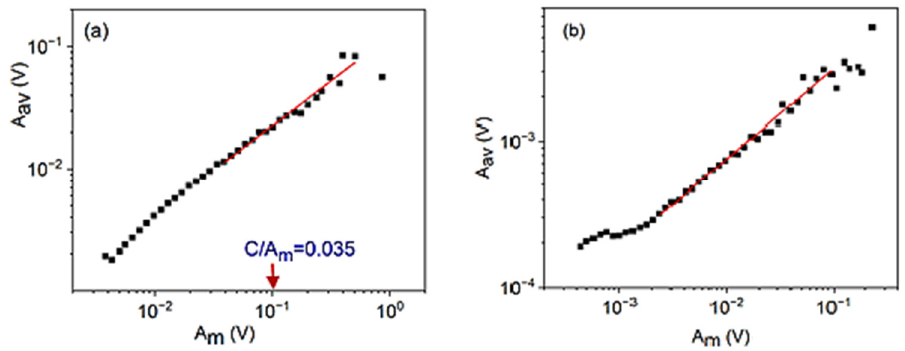
Figure 2. Relation between A av and A m for cooling (austenite to martensite) transformation in alloy A ( a ) at small, constant, external magnetic field (B = 250 mT) and for heating in alloy B ( b ) (at B = The slopes and the values of the centre of the fits are z = 0.74 ∓ 0.07 and A m C = 30 (C = 3.5 mV), as well as z = 0.62 ∓ 0.07 and A m C = 40 (C = 0.4 mV), for A and B, respectively.